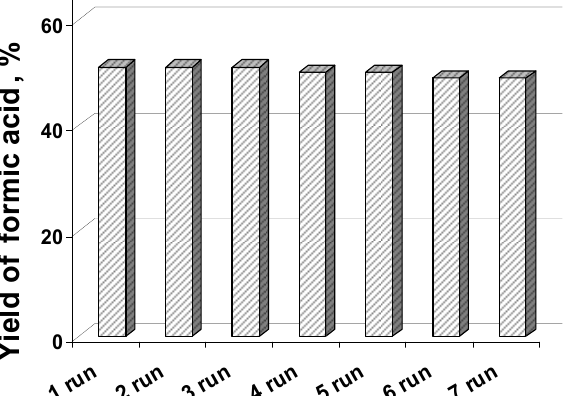
Figure 4. The yield of formic acid achieved during seven runs in the presence of Et 4 N-PMoV catalyst. (Experimental conditions: 11.9 g/L of starch (10 g/L of dry polysaccharide), 1.25 g/L of Et 4 N-PMoV, 8/1 of starch/catalyst weight ratio (108/1 of starch/catalyst molar ratio), 60 mL of the reaction volume, 2 MPa of air, 140 °C).